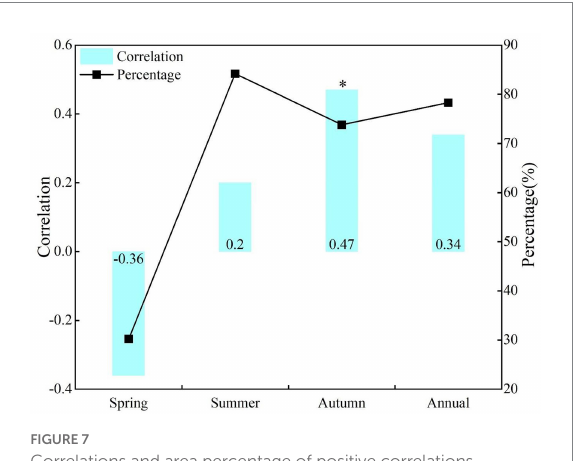
FIGURE 7 Correlations and area percentage of positive correlations between NDVI and SPEI at the lagged period effect of seasonal and annual scales.